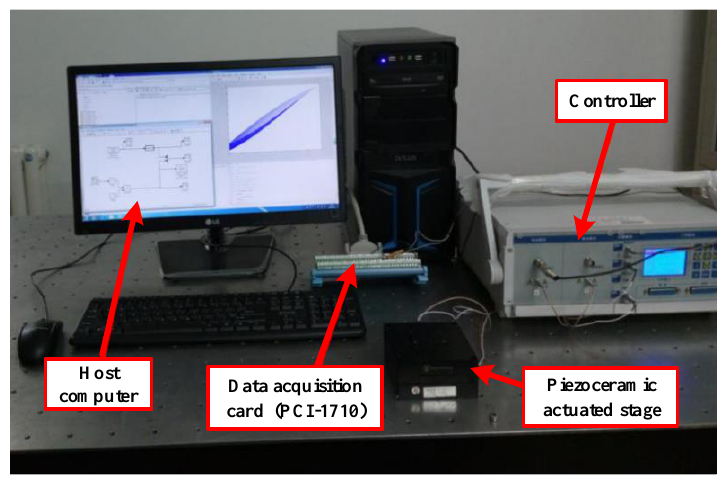
Figure 8. Experimental environment of piezoceramic actuated stage control system.